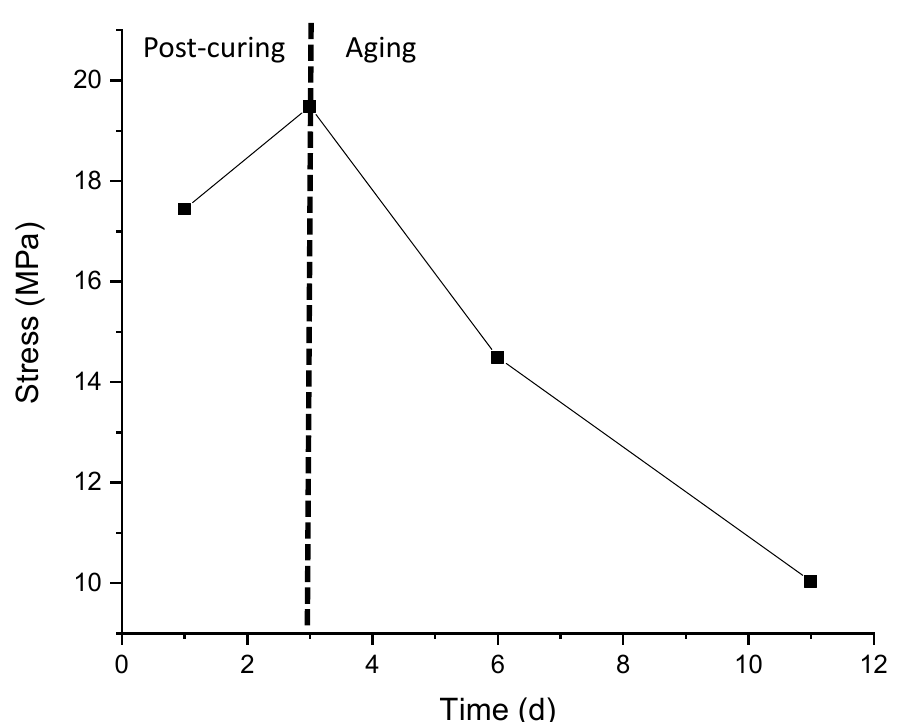
Figure 2. Dependency of stress value obtained by tensile test measurement on the annealing time (the average standard deviation is 1.69 MPa).